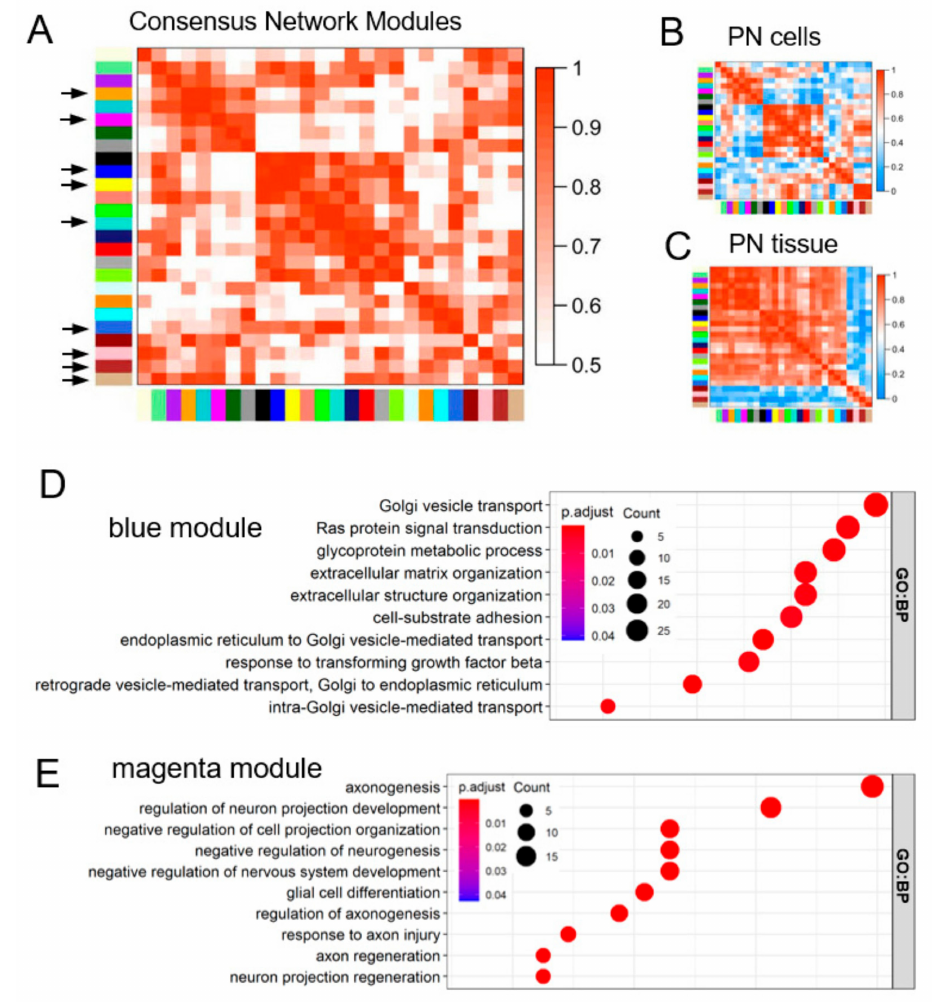
Figure 2. Preserved network modules in PN cells and primary tumors. ( A – C ) Eigengene adjacency demonstrated the preserved gene network modules (indicated by black arrows in ( A )) from PN cells ( B ) and tumor tissue ( C ). ( D , E ) Gene ontology enrichment analysis of preserved blue module ( D ) and magenta module ( E ) under the biological process category